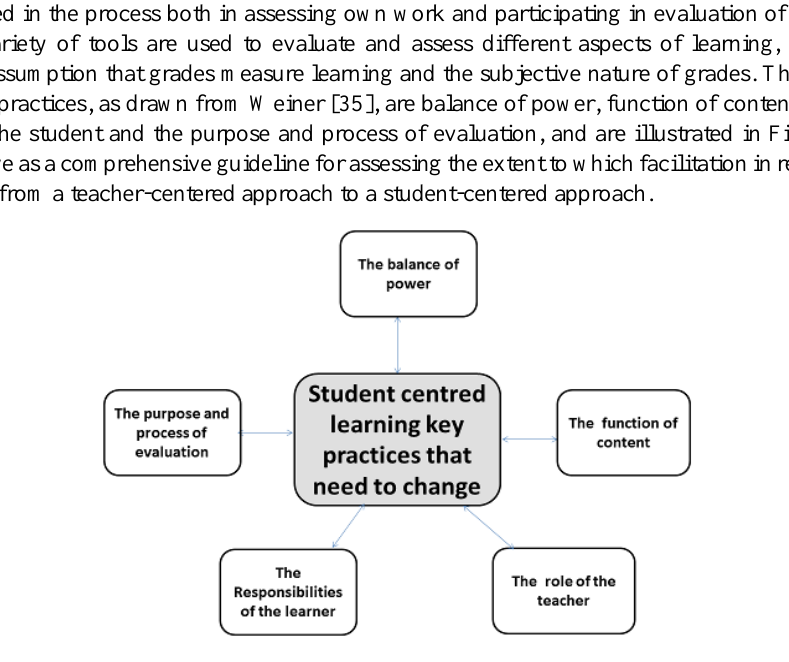
Figure 1. Student-centered learning key practices that need to